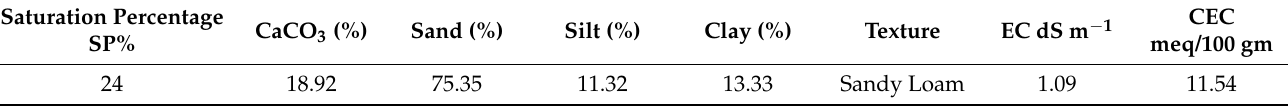
Table 1. Mechanical analysis of general empirical soil.